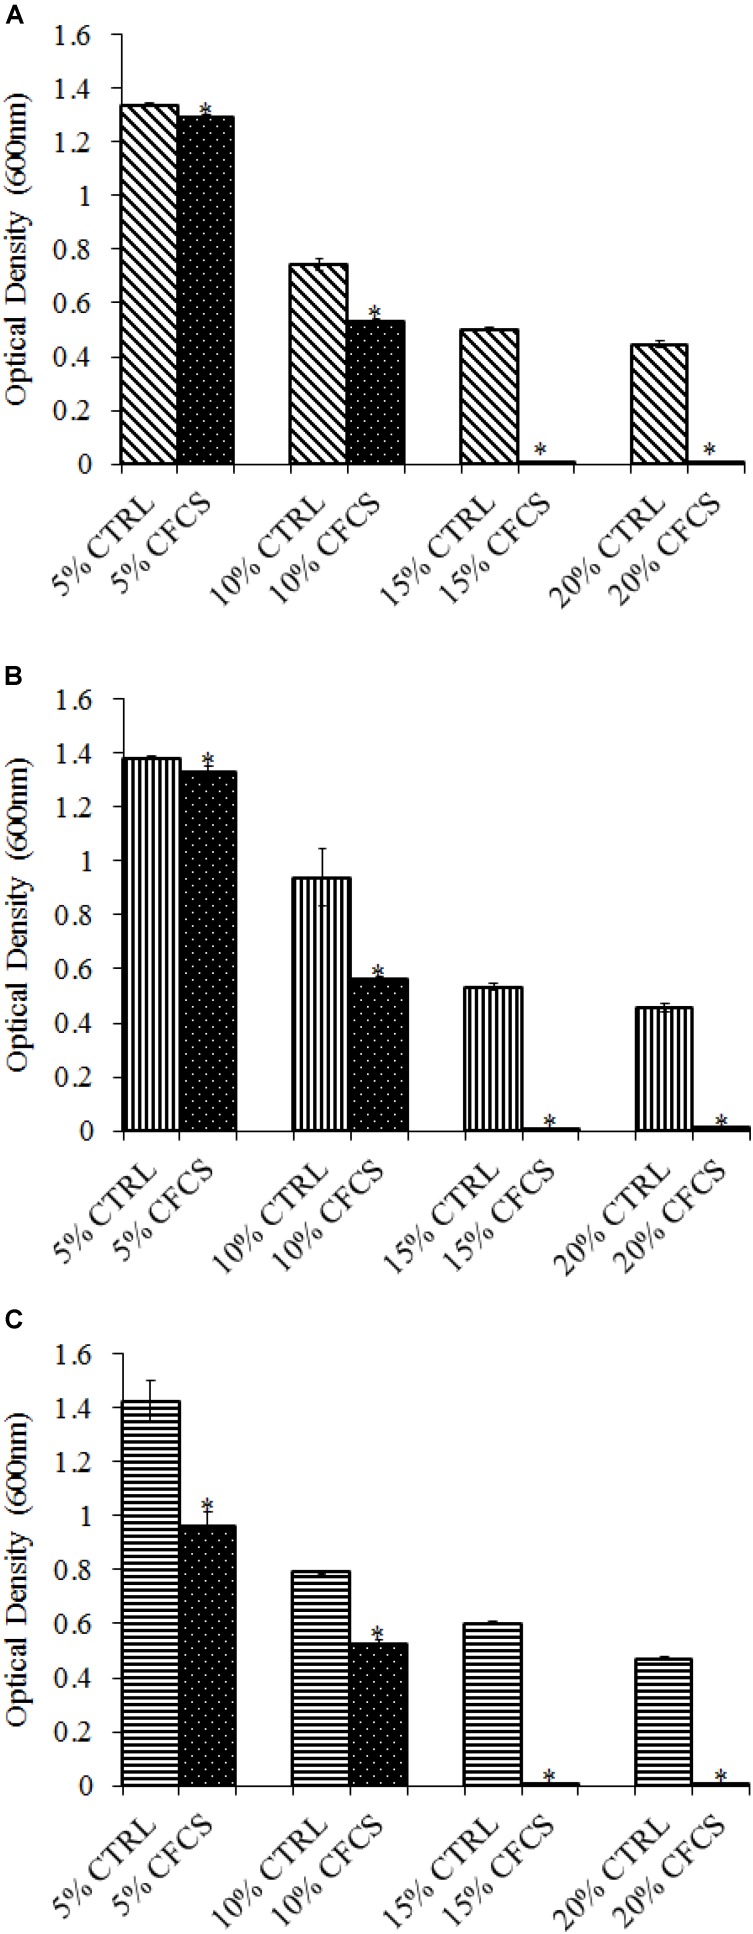
Effect of P. freudenreichii (PF) CFCS on (A)
S. Heidelberg (B)
L. monocytogenes, and (C)
E. coli O157: H7. TSB containing S. Heidelberg, L. monocytogenes, or E. coli O157: H7 (106 CFU ml−1) were treated with 5, 10, 15, or 20% (v/v) of cell-free culture supernatant (CFCS) of PF. The pH of TSB was adjusted to match the pH of treatments having CFCS were inoculated with the respective pathogen and used as positive controls (CTRL) for each CFCS concentration. The pathogen survival was determined by determining optical density (OD = 600 nm) after incubating samples at 41°C for 24 h (n = 6; ∗P < 0.05). Bacterial counts were represented as OD600 ± standard error.